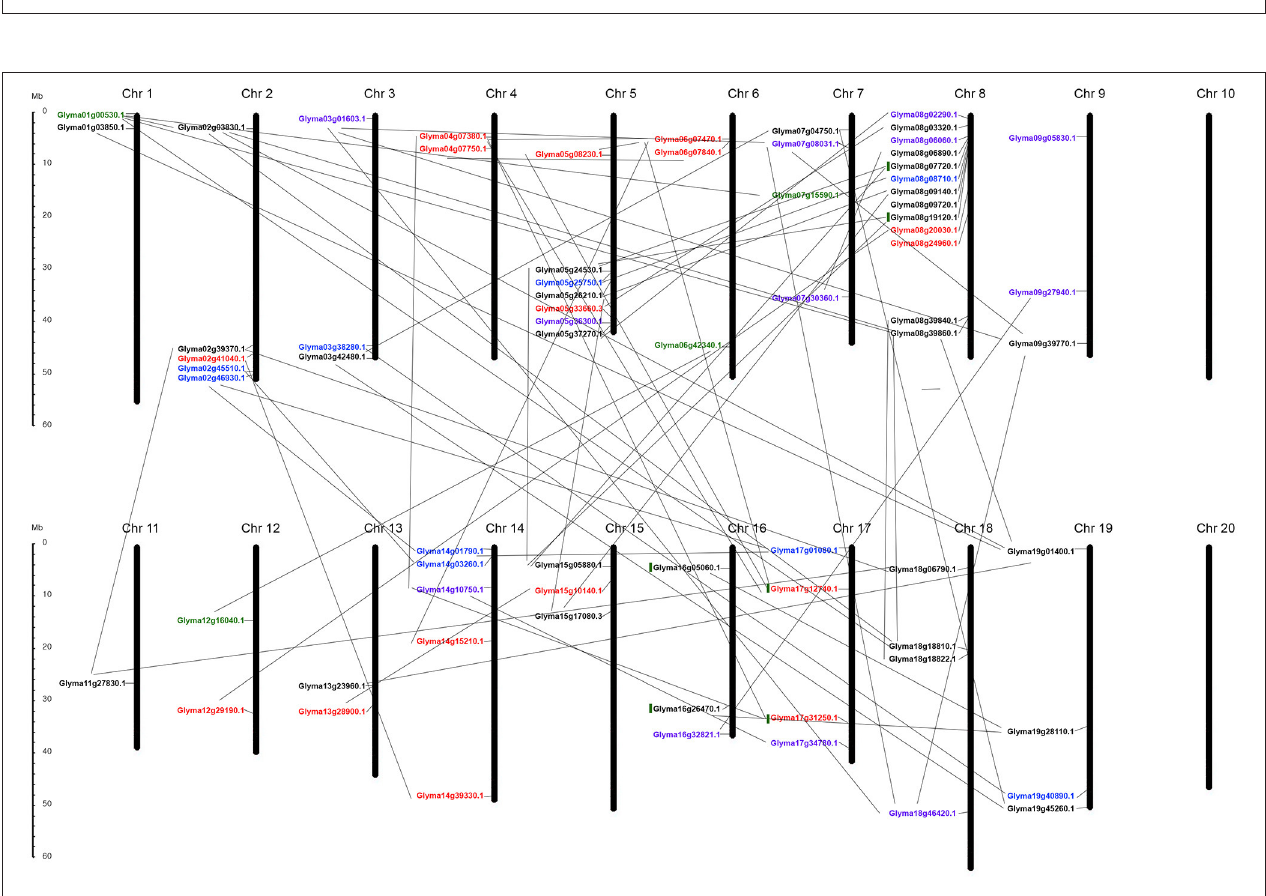
FIGURE 4 | Phylogenetic tree of the putative KEA family in soybean, with exon structure and splice site analysis. (A) Three clearly distinguished clades are present in soybean. Referenced genes are indicated with dotted lines with their NCBI names. (B) Exons colored yellow are conserved in length among all soybean KEA genes.